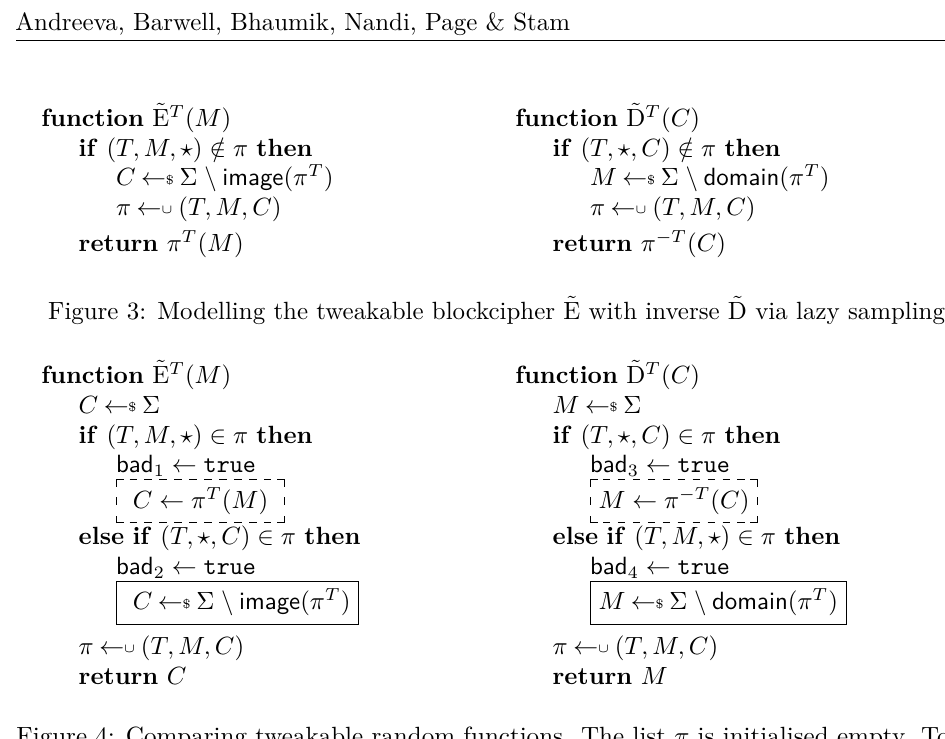
Figure 4: Comparing tweakable random functions. The list π is initialised empty. To be a uniform sampler, we include none of the boxed code. A tweakable random function includes the unboxed code and also the code in dashed boxes. Finally, a tweakable random permutation uses all of the code. Thus we see the three constructions (and the various hybrids of them) are all